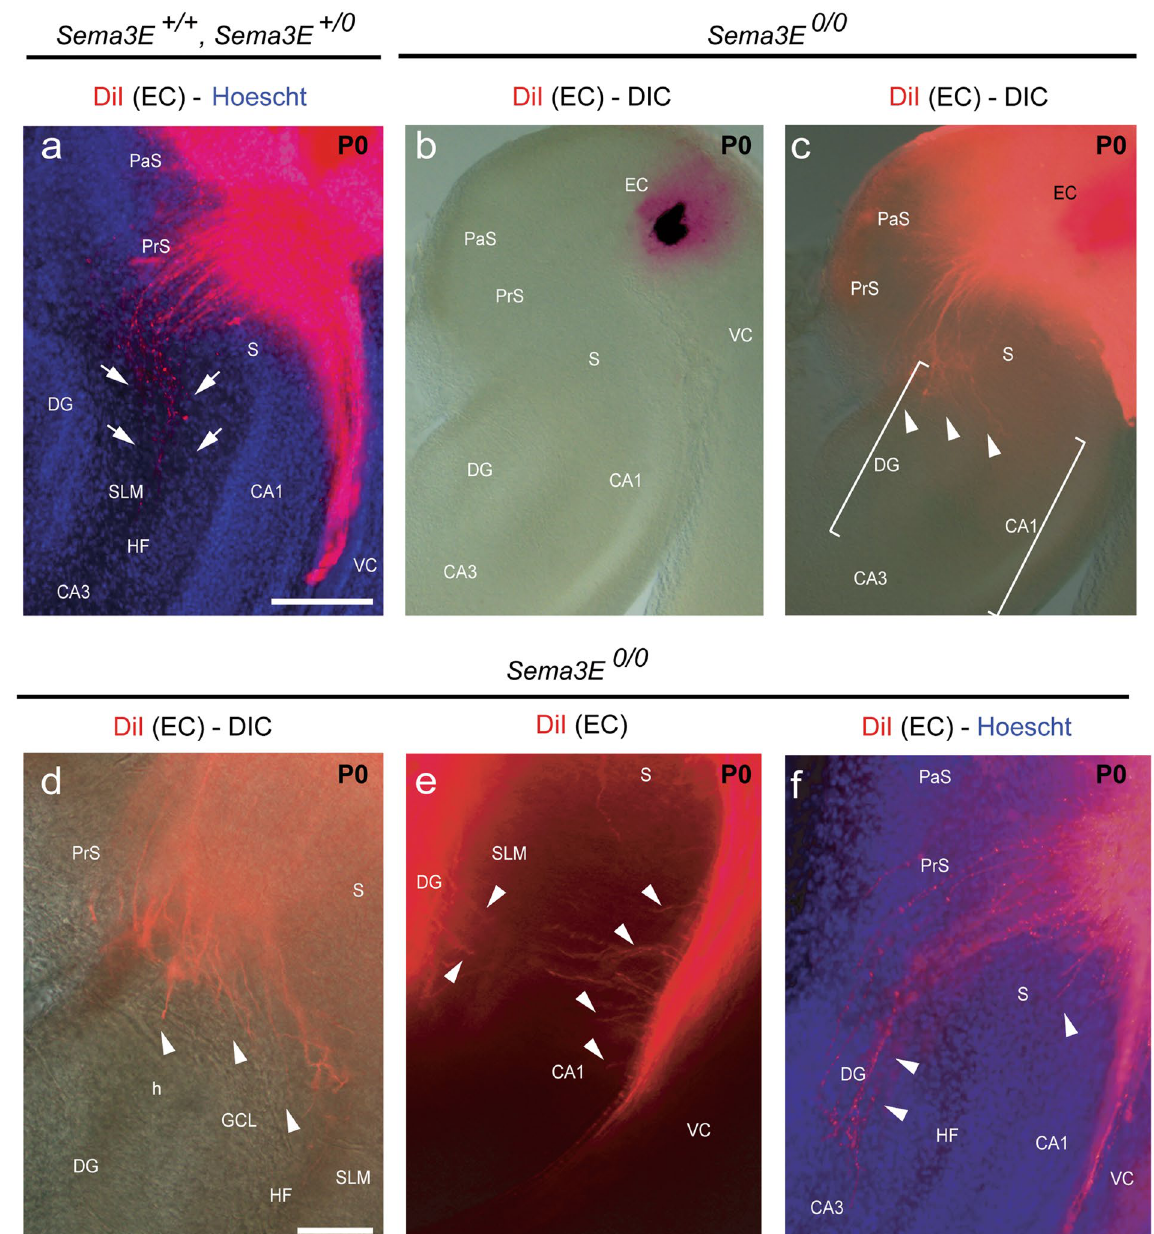
Figure 3. Pattern of entorhino-hippocampal innervations in Sema3E-deficient mice after DiI injections in the entorhinal cortex at P0. ( a ) In wild-type and Sema3E + /0 mice, entorhinal fibers are restricted to the stratum lacunosum-moleculare (arrows) and the white matter. ( b – f ) In Sema3E 0/0 mice the EH connection is formed, but ectopic axons cross the hippocampal fissure, entering the dentate gyrus or the CA1 (arrowheads in b – f ). Abbreviations as in Fig. 1 and GCL = granule cell layer; h = hilus; HF = hippocampal fissure; PrS = presubiculum; SLM = stratum lacunosum- moleculare. Scale bar: a = 250 μ m pertains to ( b – c ); d pertains to ( e – f ) = 100 μ